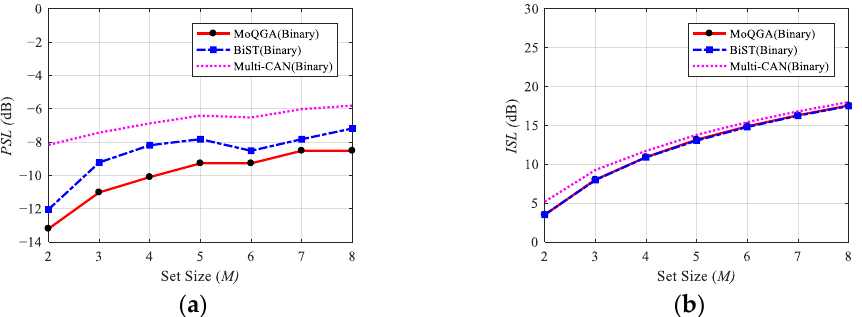
Figure 12. PSL and ISL values of MIMO radar binary phase code sequence set obtained by MoQGA and other methods under different sequence set size and N = 32. ( a ) PSL ; ( b ) ISL .